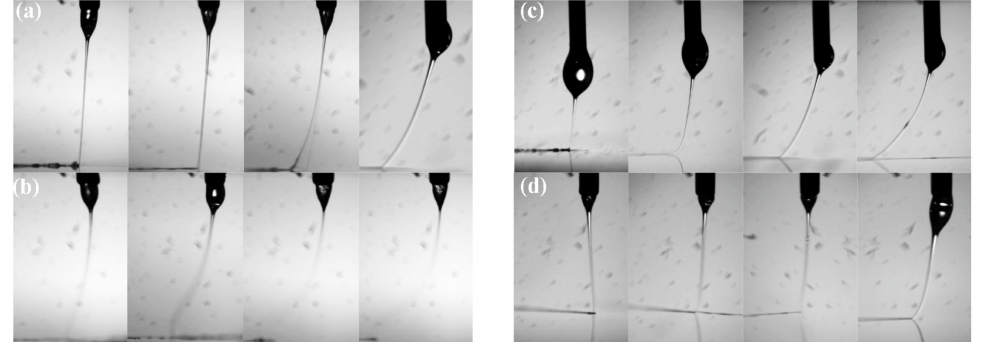
Figure 4. The behavior of charged jets under different spinneret configurations when the collector moving speed was 1 mm/s, 5 mm/s, 10 mm/s, and 20 mm/s, respectively. ( a ) Without assisted airflow when L = 0.5 mm, the applied voltage was 2.3 kV; ( b ) with assisted airflow of 25 kPa when L = 0.5 mm, the applied voltage was 2.3 kV; ( c ) without assisted airflow when L = 2 mm, the applied voltage was 2.0 kV; ( d ) with assisted airflow of 25 kPa when L = 2 mm, the applied voltage was 2.0 kV.